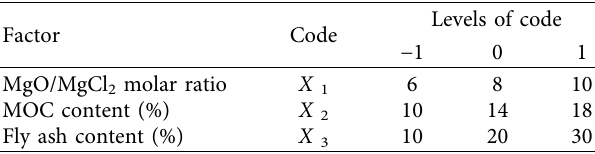
Table 5: Infuence factors and their levels of code for BBD.